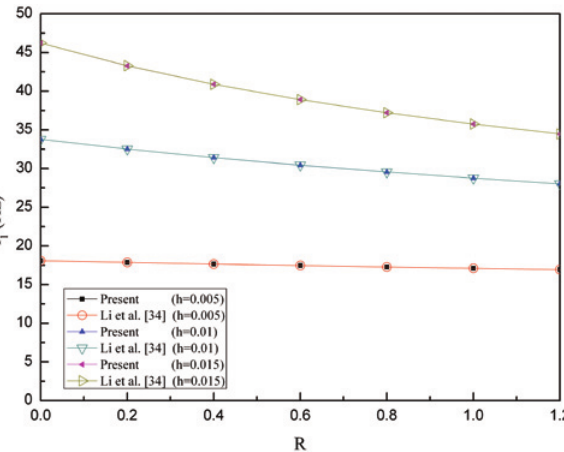
Figure 7 The fourth-order frequency of the clamped square com- posite laminates with uniform bonding imperfections.